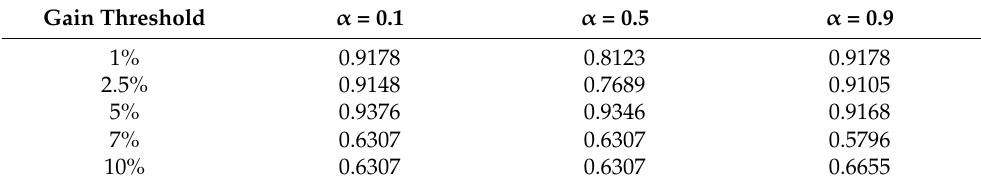
Table 11. First linear discriminant analysis (LDA) coefficient (proportion of trace) for different values of gain threshold and α